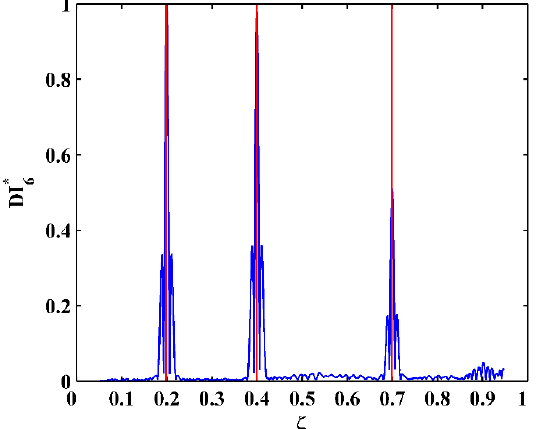
Figure 8. NMDIs for the ( a ) third, ( b ) fourth, and ( c ) fifth mode shapes (locations of cracks are indicated by red lines).